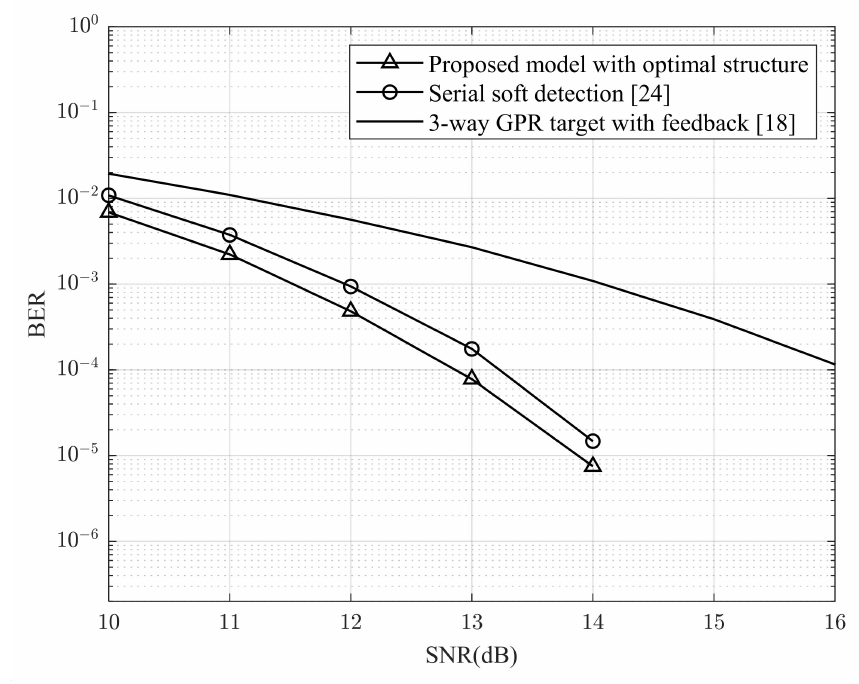
Figure 5. BER performance of the proposed model with 10% TMR [18,24].